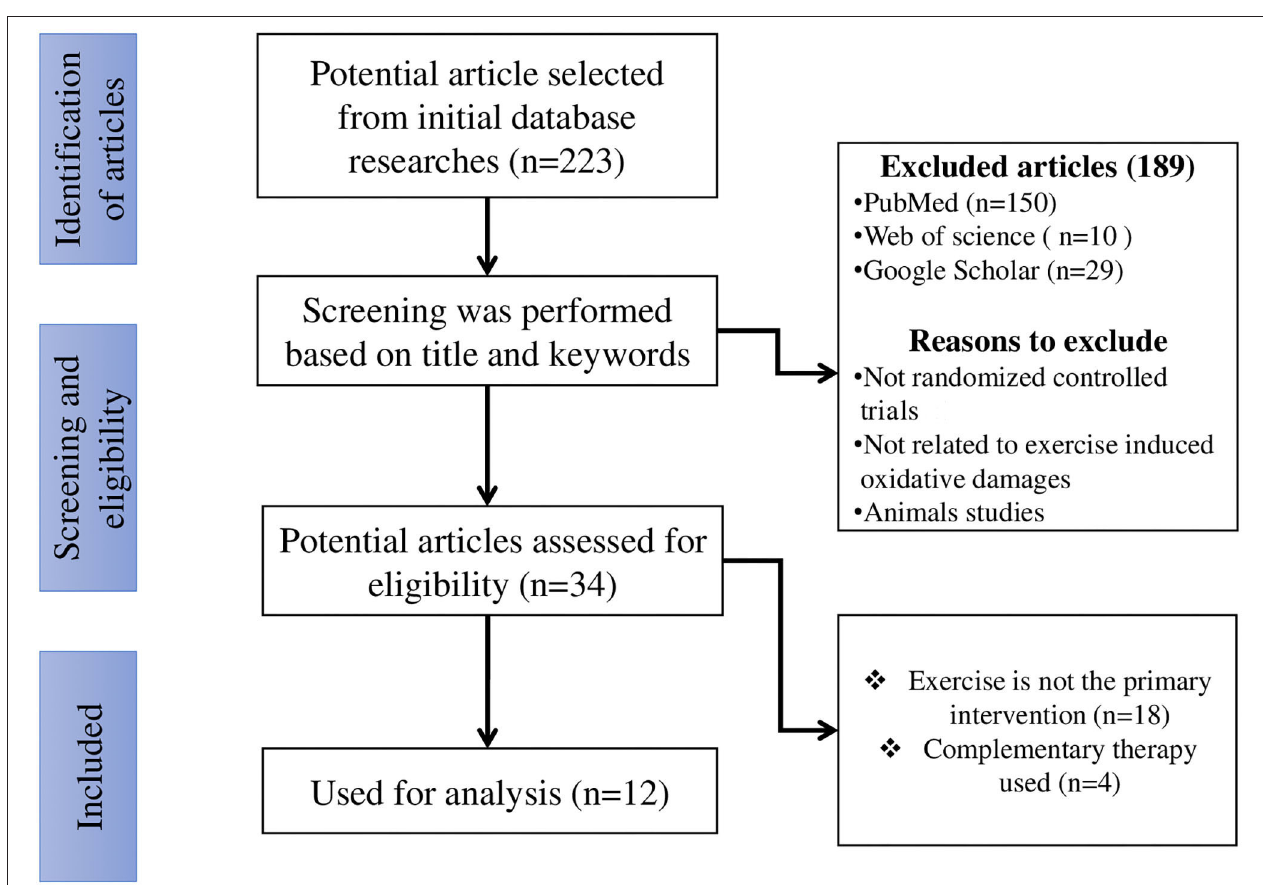
FIGURE 1 | The search flowchart for screening